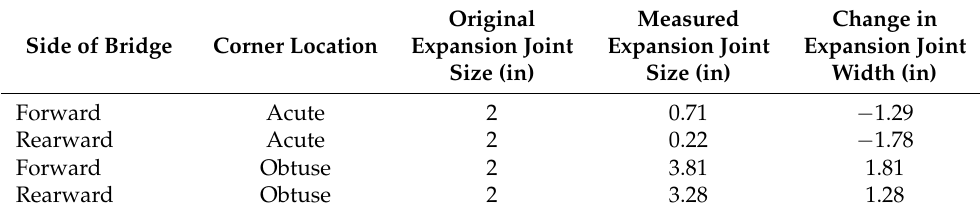
Table 1. End Diaphragm Displacements 26 February